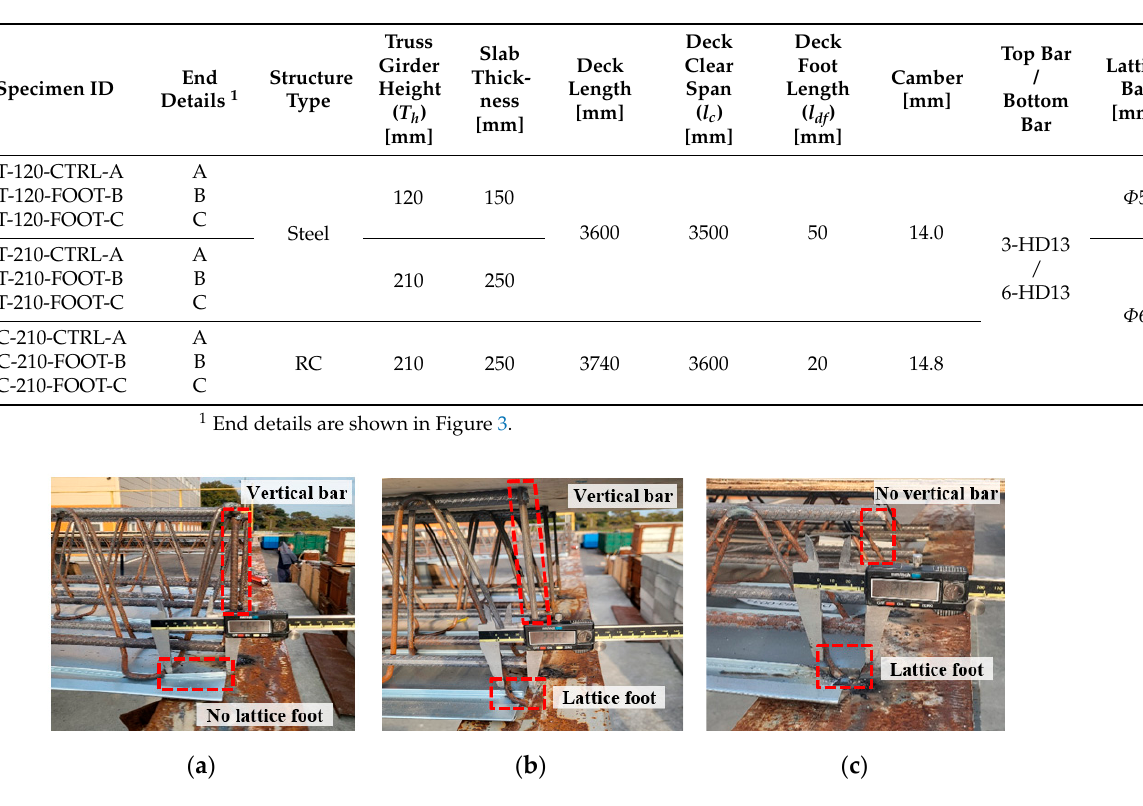
Table 1. Details of the test specimens.